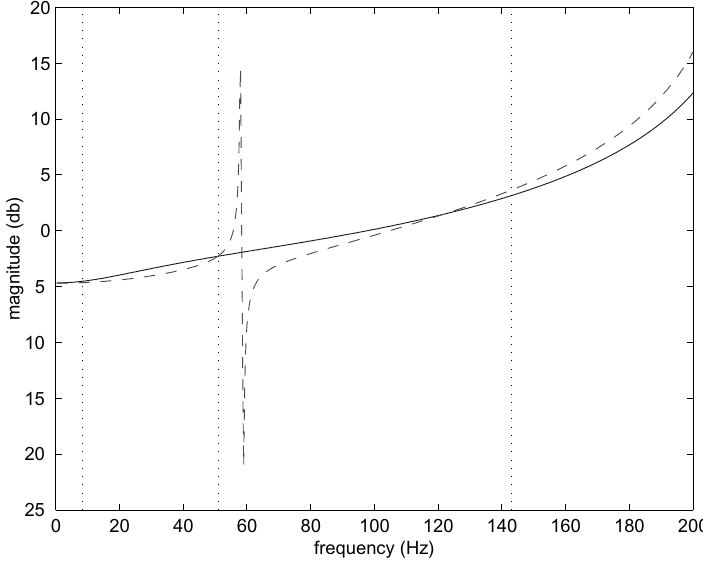
Fig. 17. Transmissibility function between point 7 and point 8 for undamaged structure for loading case 1 (full line; force applied in DOF 1) and damaged structure for loading case 2 (dashed line, force applied in DOF 3). become independent of the loading condition. This property can clearly be seen in Fig. 15, where the transmissibility function between point 7 and point 8 during the two different loading conditions is shown. The vertical dashed lines are located at the resonance frequencies of the structure. A zoom around the resonance frequencies can be seen in Fig.